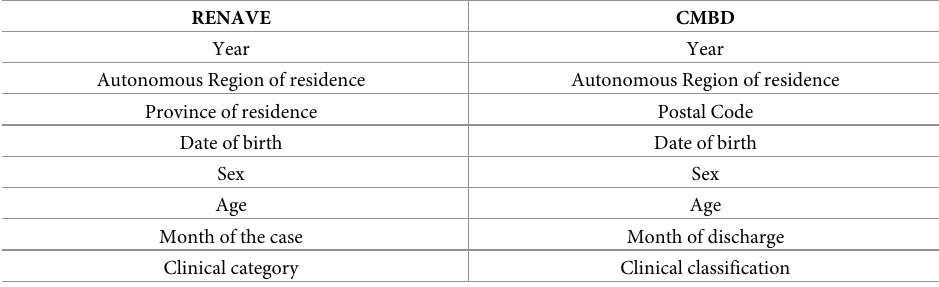
Table 1. Overlapping